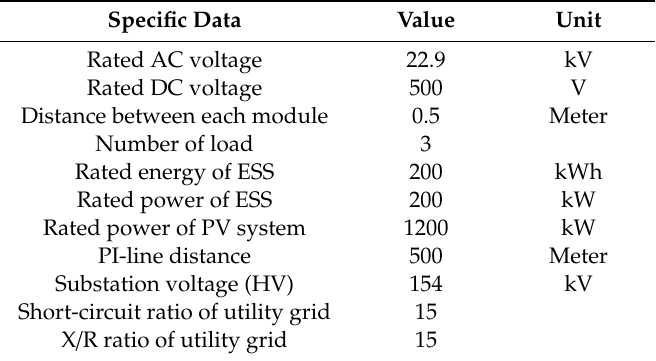
Figure 6. Simulated distribution network including MW-scale PV / ESS. Table 1. Numerical data for the simulation.